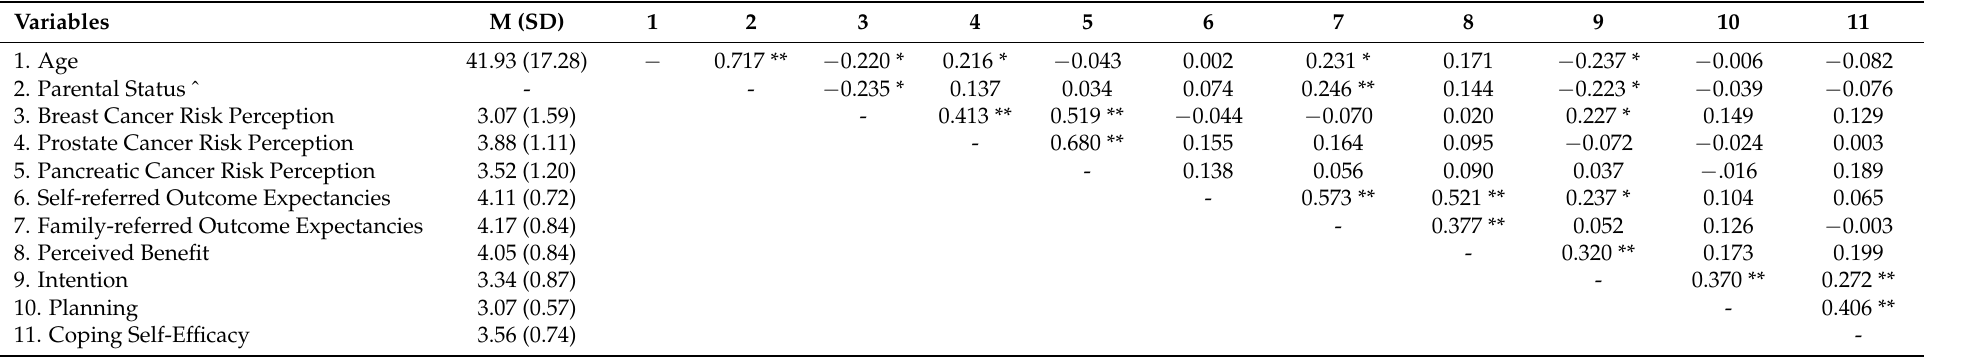
Table 1. Means, standard deviations, and correlations between the main variables in the